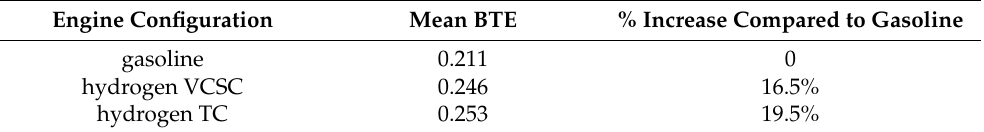
Table 2. The mean BTE of the three engine configurations in a conventional vehicle.